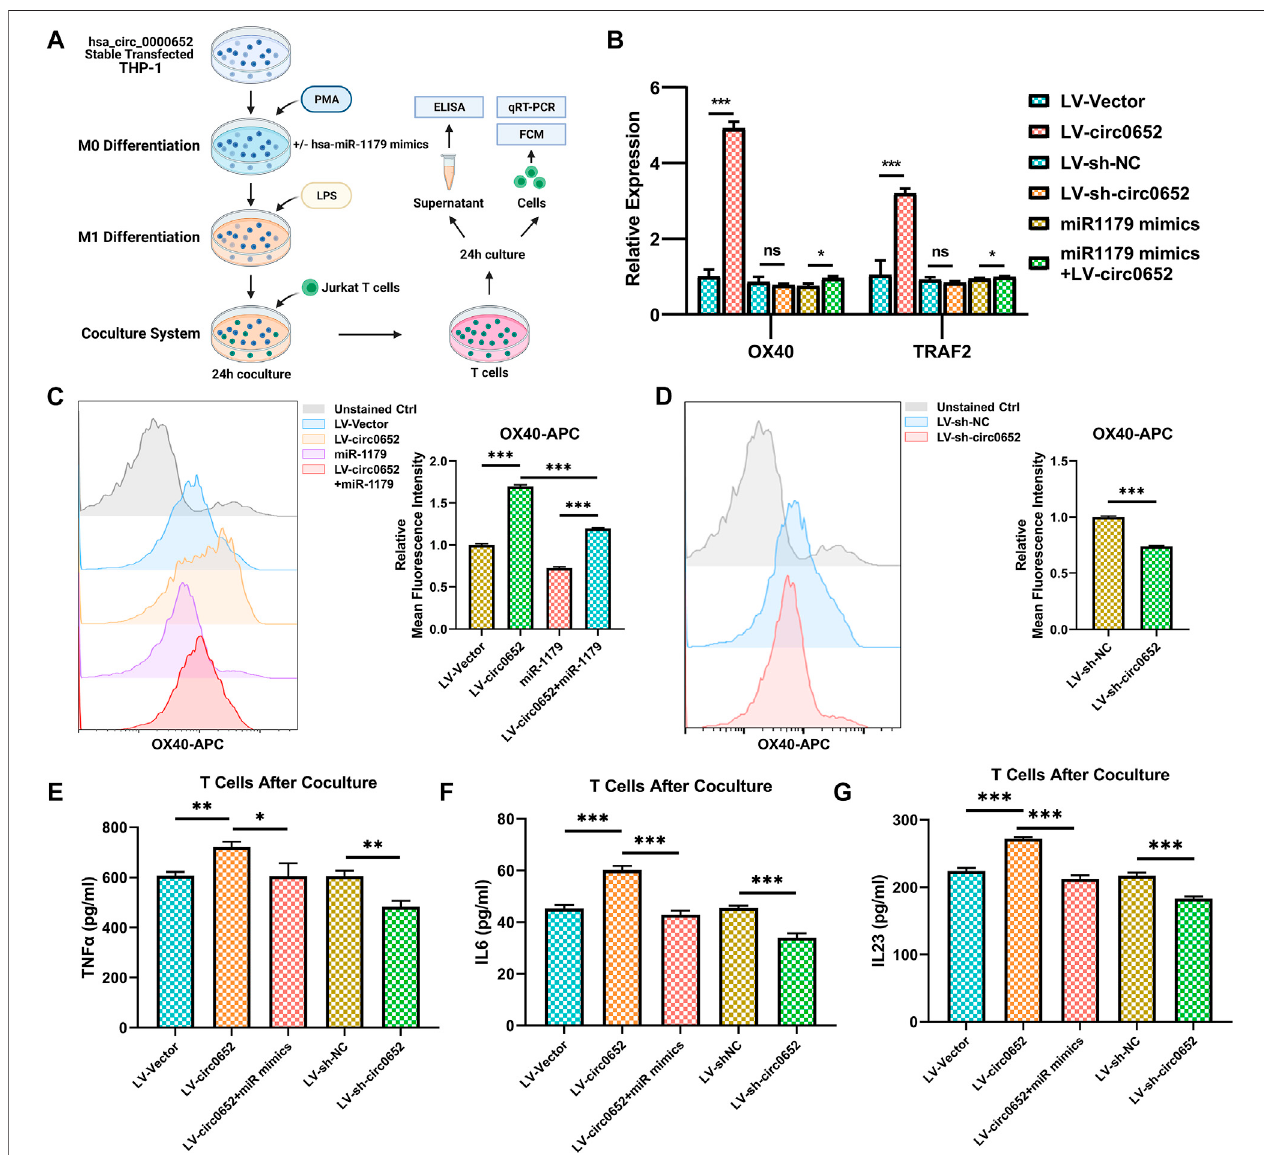
FIGURE 6 | Hsa_circ_0000652 regulates in fl ammation caused by OX40/OX40L interaction between macrophages and CD4 + T cells. (A) Schematic illustration of macrophages and CD4 + T-cell coculture system. (B) QRT-PCR analysis of OX40 and OX40L in CD4 + T cells after being cocultured with hsa_circ_0000652 stably expressed THP-1 cell lines with or without hsa-miR-1179 mimics (n (cid:2) 3). (C,D) Flow cytometry of OX40 in CD4 + T cells after coculturing with hsa_circ_0000652 stably expressed THP-1 celllineswithorwithouthsa-miR-1179 mimics (n (cid:2) 3). (E – G) ELISAanalysisofcytokinelevelsinthesupernatantofCD4 + Tcellsafter coculturing with hsa_circ_0000652 stably expressed THP-1 – derived macrophages with or without transfection of hsa-miR-1179 (n (cid:2) 3). Data are presented as mean ± SD. ns: p ≥ 0.05; * p < 0.05; ** p < 0.01; *** p < 0.001. Each experiment was performed at least in triplicate.